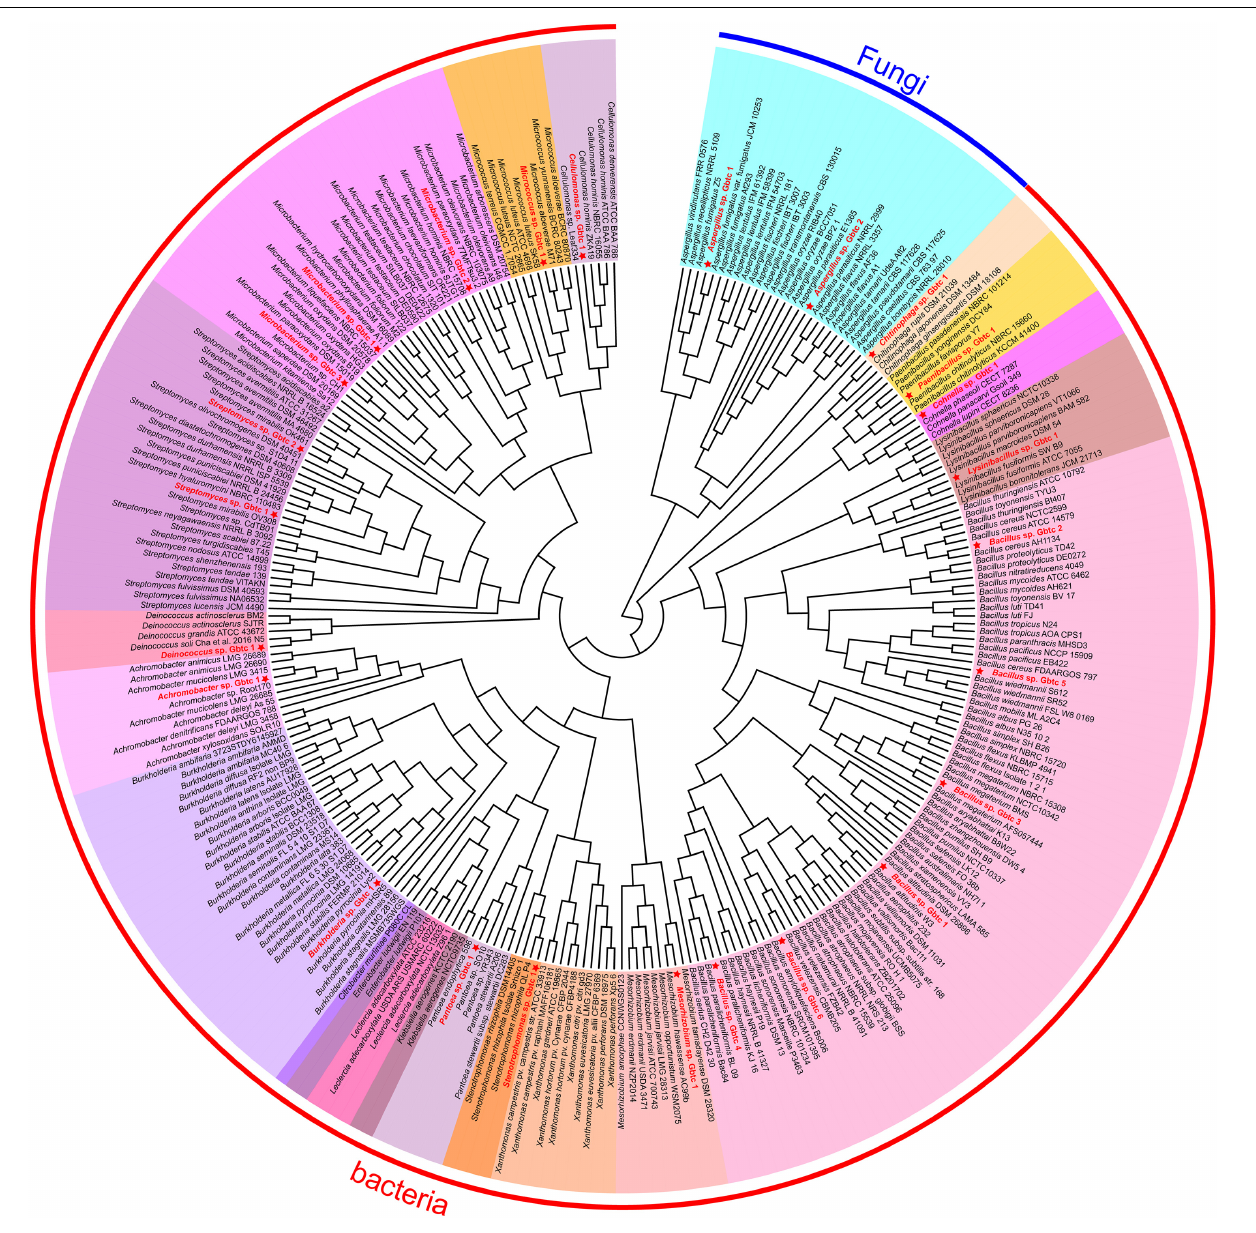
FIGURE 2 | The phylogenetic tree of all isolates and other open-access strains based on the whole genomes. The red font strains with five-pointed stars ahead indicated the Ginkgo isolates. The same genus individuals were backgrounded with the same color. The arc-shaped line segment on the outermost circle represented the Kingdom of bacteria and